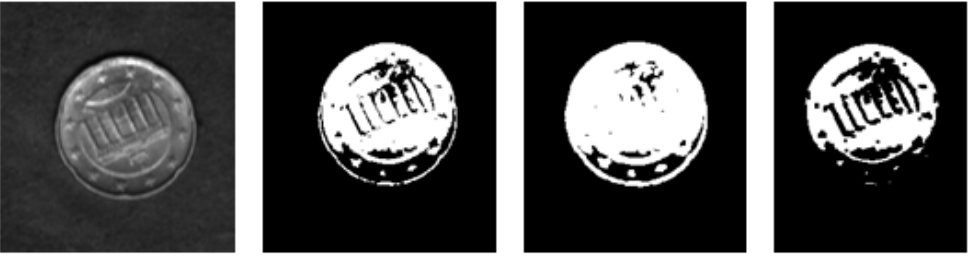
Figure 8. Results for the different pre-processes used. Left to right: the real image, the threshold result, the expand result and the shrink